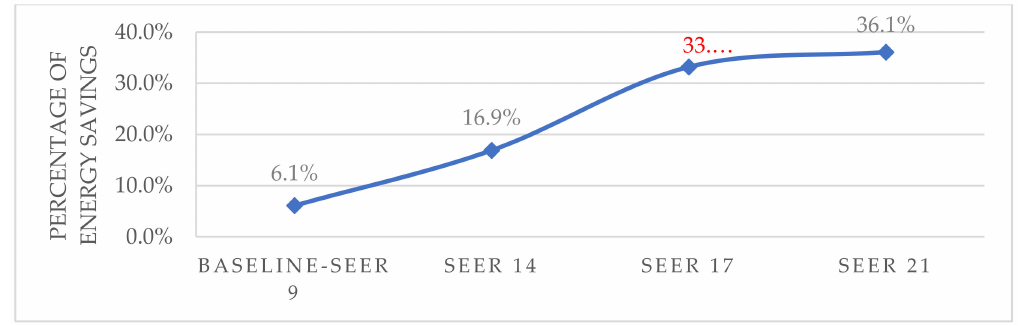
Figure 14. The e ff ect of variation of SEER value on the total annual energy consumption of the